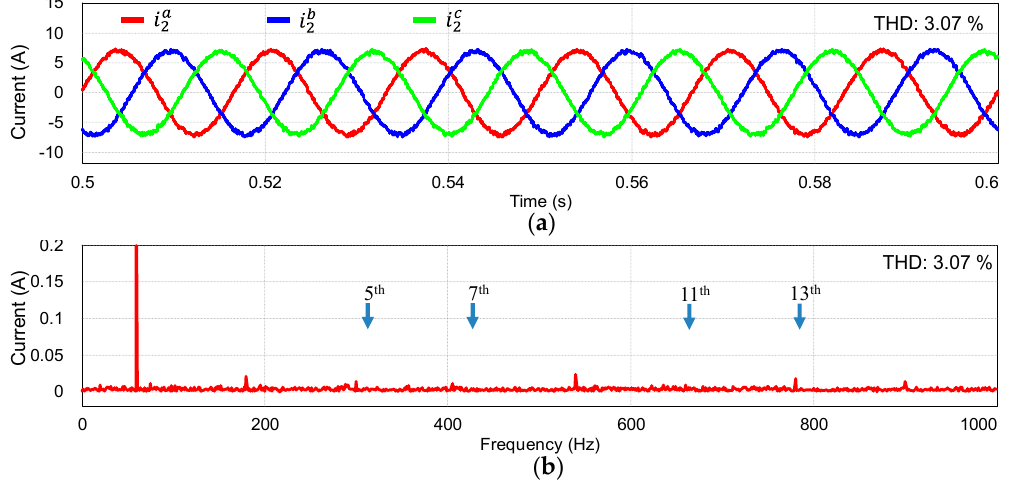
Figure 10. Simulation results of the proposed controller under the LCL filter parameter variations under distorted and imbalanced grid voltages with e a drop to 83.33% of the nominal value: the filter capacitance C f decreases from 4.5 µ F to 3 µ F. ( a ) Three-phase grid currents; ( b ) FFT result of phase- a current.